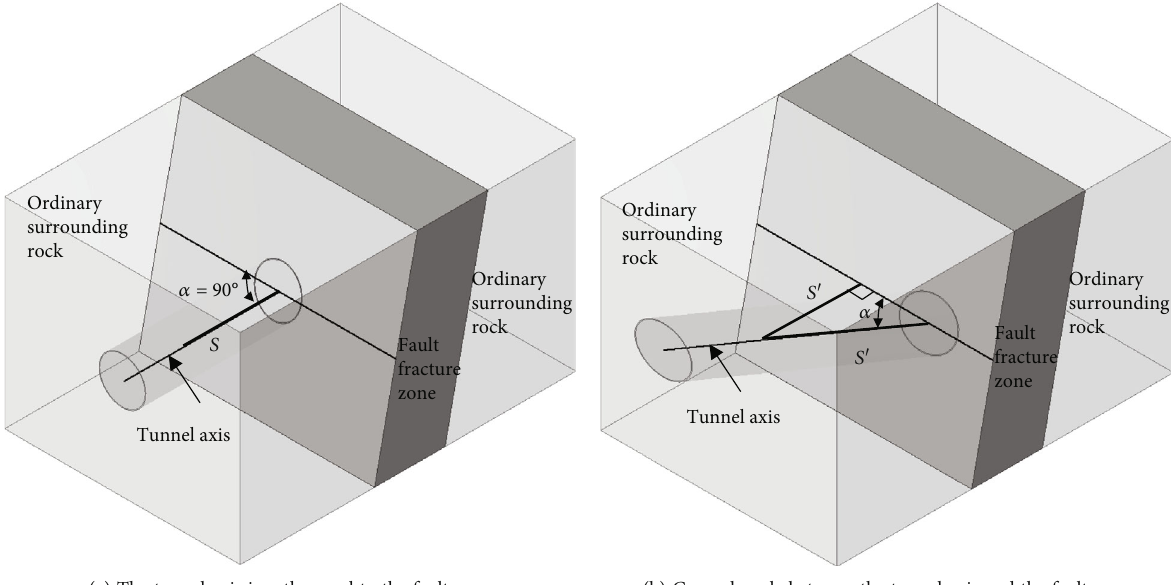
Figure 3: Schematic diagram of the intersection of the tunnel axis and the fault